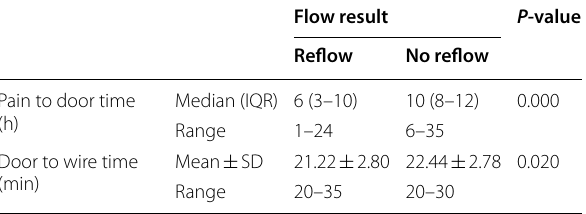
Table 2 Ischemic times of the studied patients